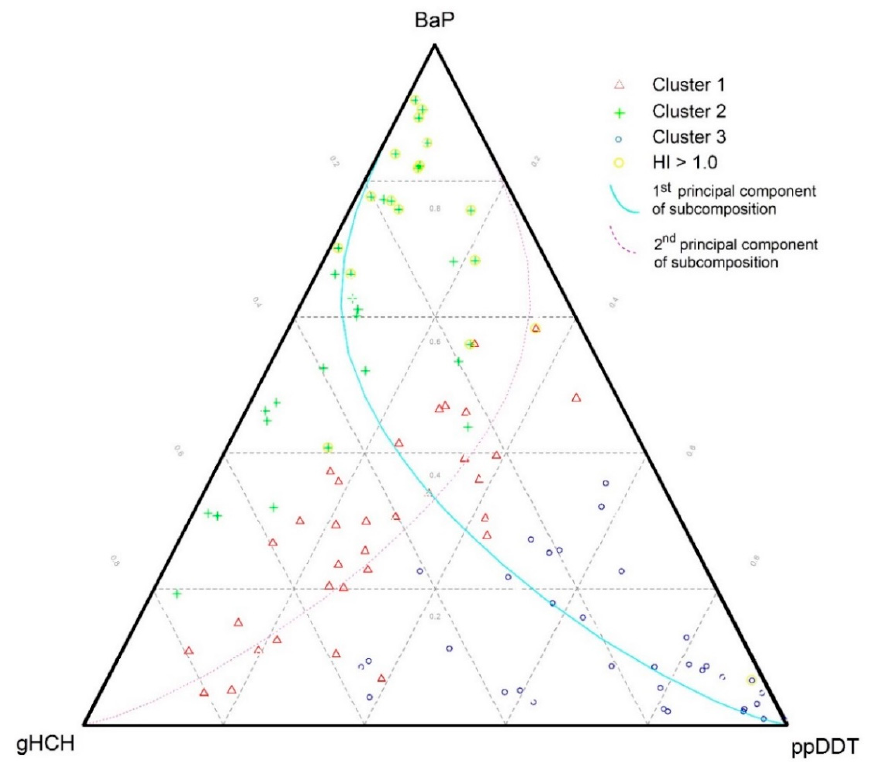
Figure 2. Ternary diagrams of the subcomposition (benzo(a)pyrene (BaP), gamma-HCH (gHCH), ppDDT) with distinguished three-group fuzzy partitions and the first two principal components (PCs) of the presented subcomposition (note that the samples with HI HUMAN > 1.0 are highlighted with a yellow circle).